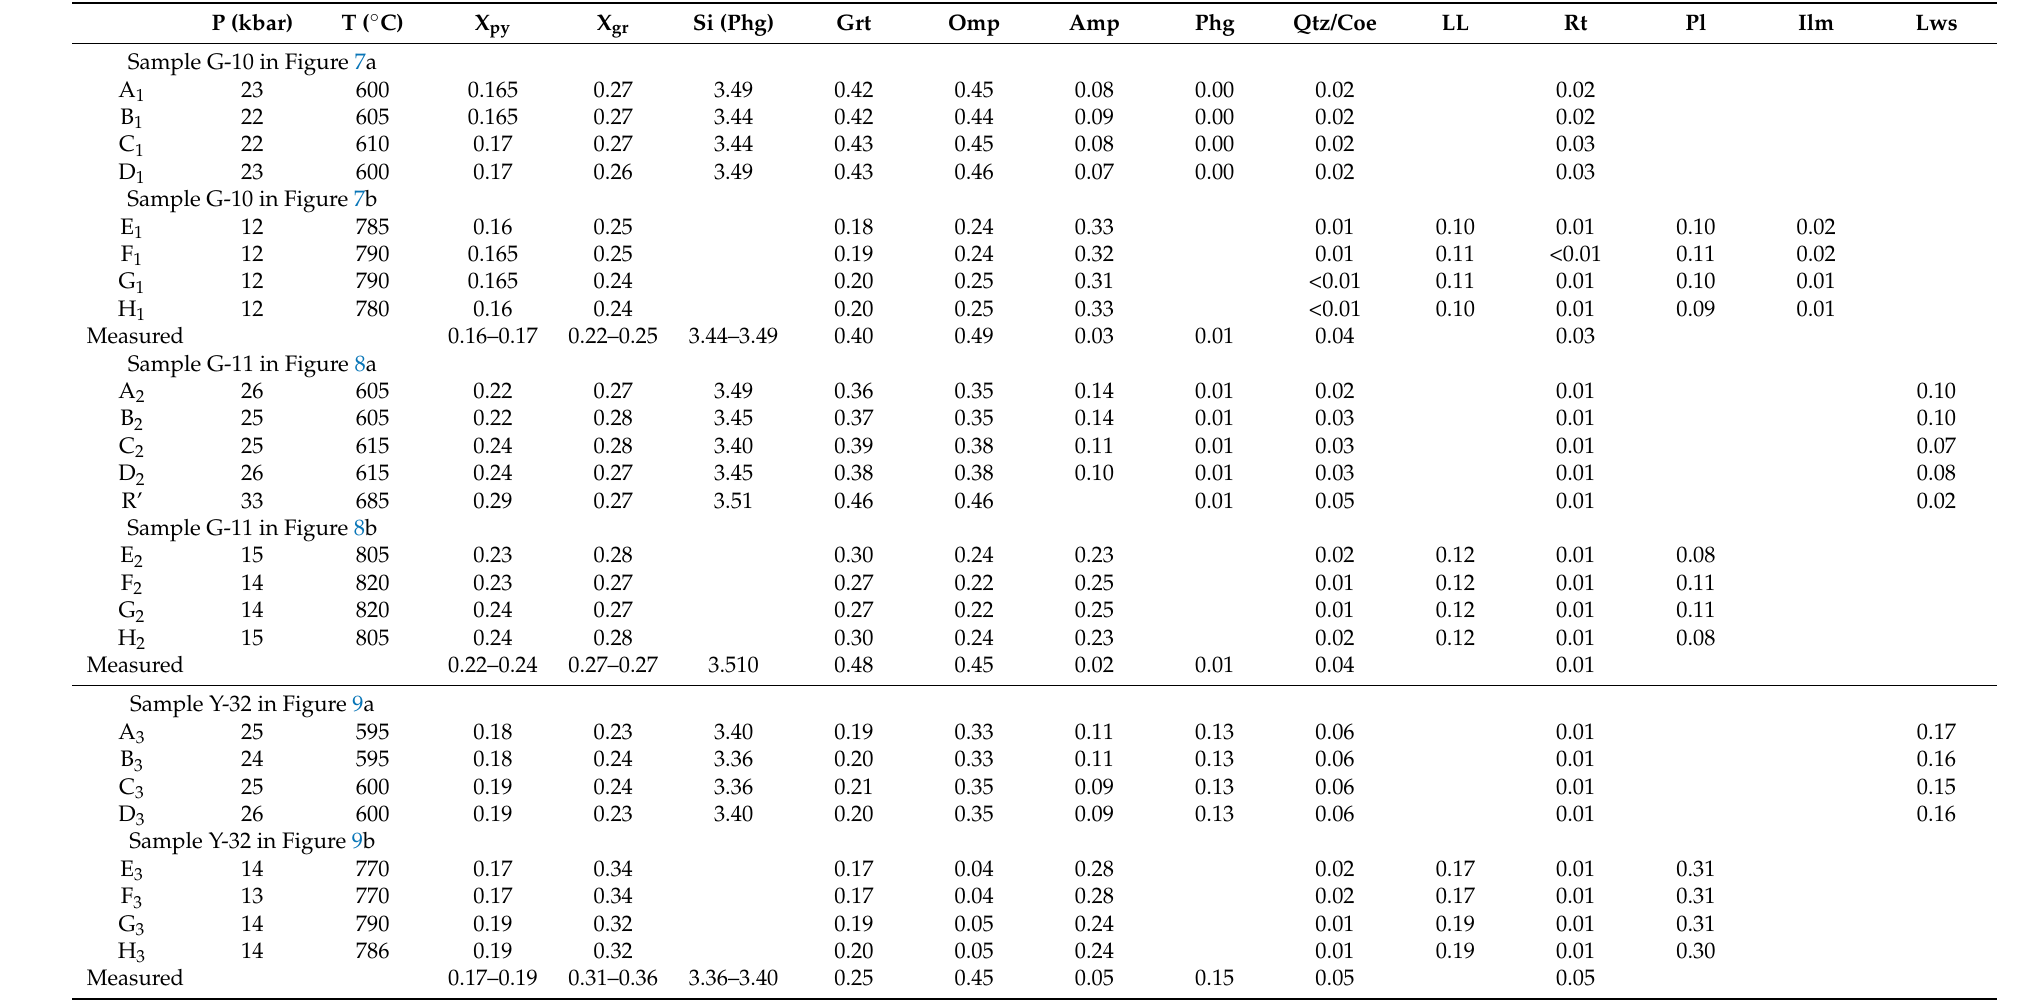
Table 3. Comparison of the calculated mineral compositions and modal proportions (on one-oxide basis) with those measured in the studied